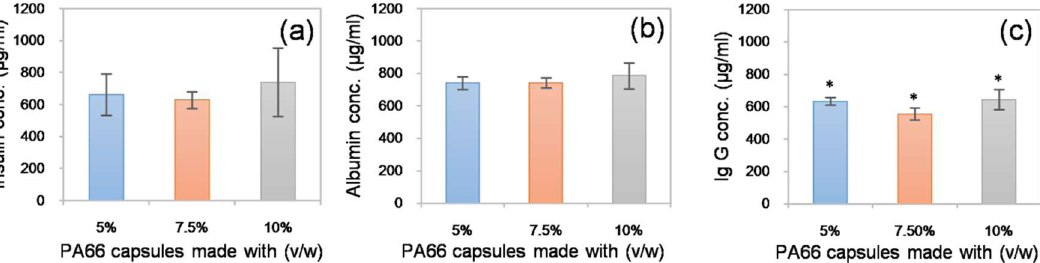
Figure 5. Protein diffusion study: Biomolecules such as insulin ( a ), albumin ( b ), and Ig G ( c ) loaded (1 mg/mL) into the sacrificial core electrospun capsules, were found to diffuse through the membrane into the incubation buffer. * denotes statistical differences at p < 0.05.